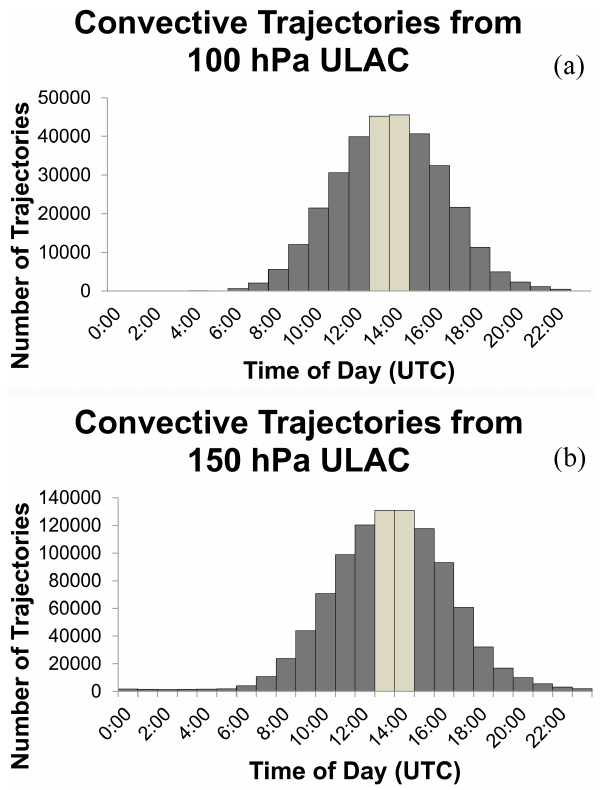
Fig. 9. Histograms of the time of day (UTC) that convective back trajectories starting from the ULAC at 100hPa (a) and 150hPa (b) crossed the PBLH.